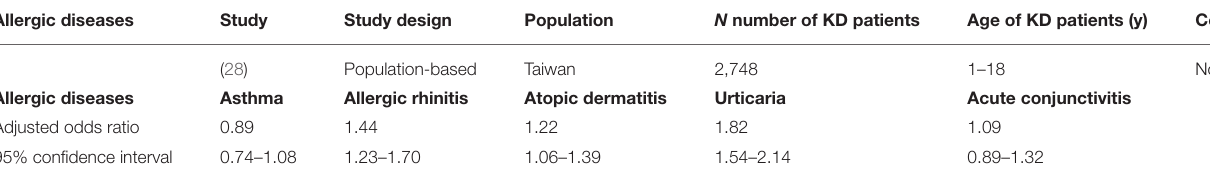
TABLE 5 | Allergic diseases and subsequent risk of Kawasaki